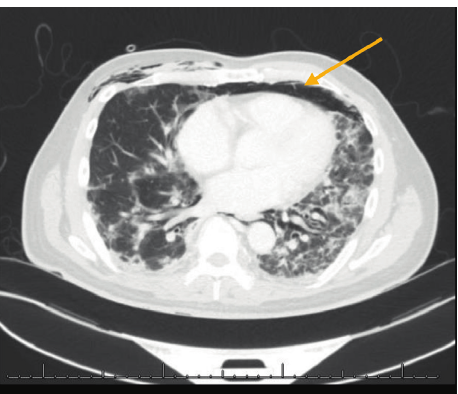
Figure 1: Lung CTscan demonstrating SPM (arrow) prior to lung transplant.